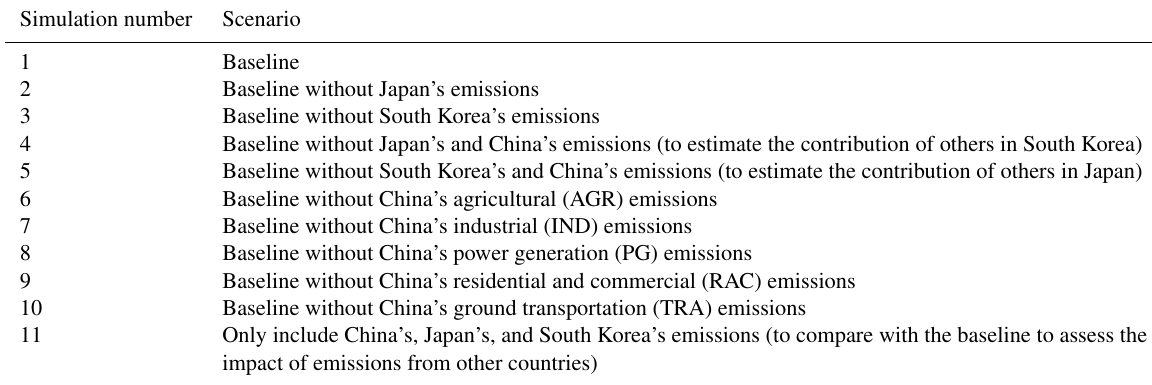
Table 1. List of model